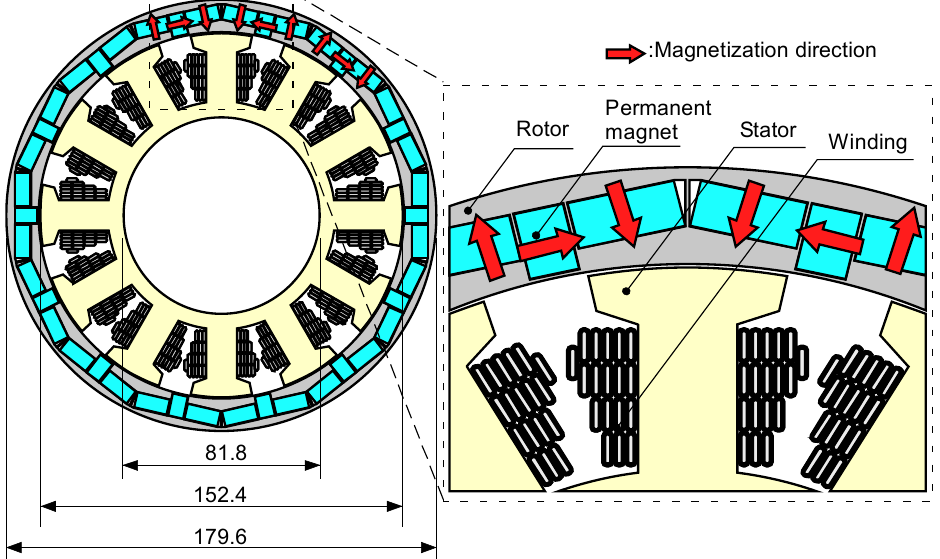
Figure 1. Structure of a drone motor (unit: mm).